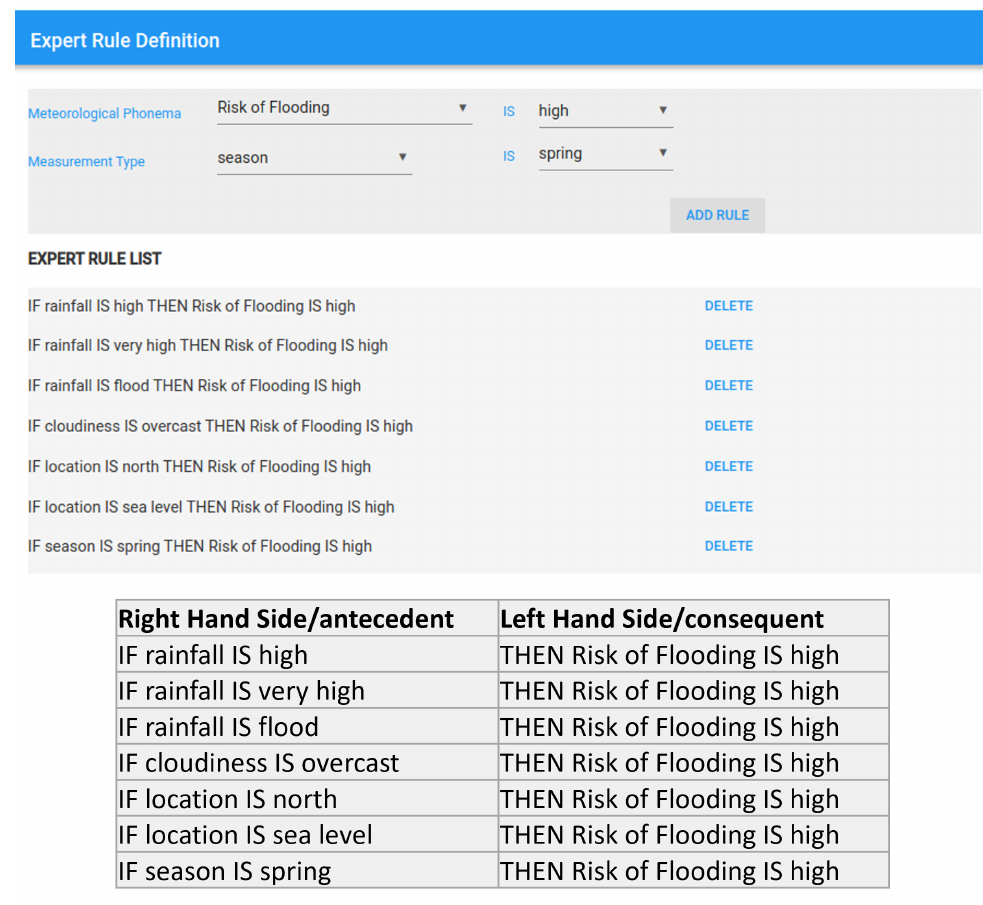
Figure 5. Expert rule definition UI.